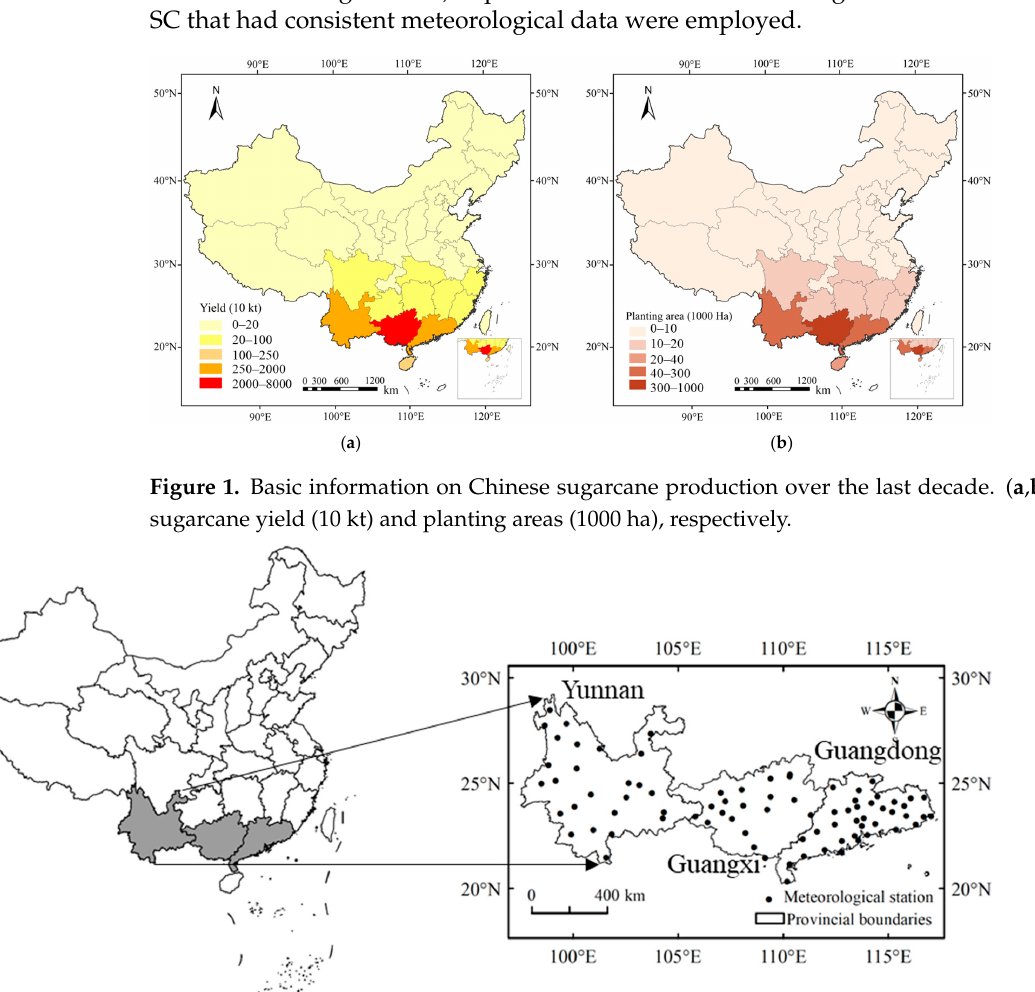
Figure 2. Description of the study region. The colored area on the left-side subgraph indicates southern China, including Yunnan, Guangxi, and Guangdong provinces. The points on the right-side subgraph indicate the national level meteorological stations that were employed in this work.